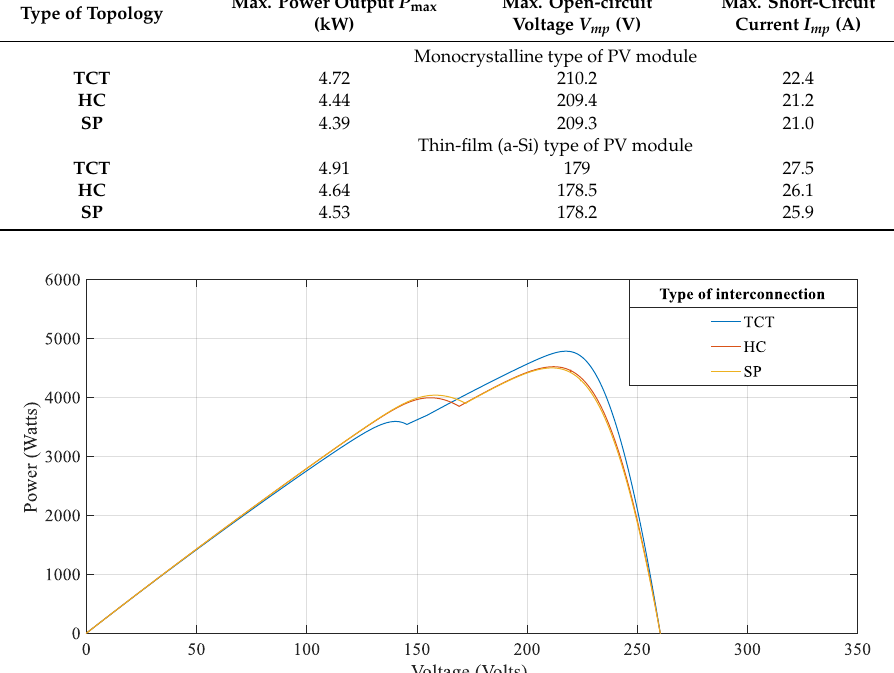
Figure 8. P-V curve for open- circuit fault ‘F1′ (thin-film PV).